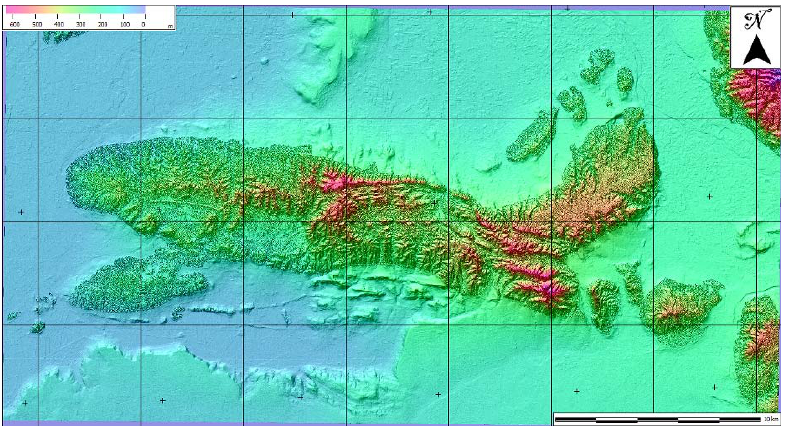
Figure 7. High-resolution raster DSM for Mausanne les Alpilles (France), purpose-made with a Leica ADS40 digital camera and provided by the Principal-Investigator European Commission-Joint Research